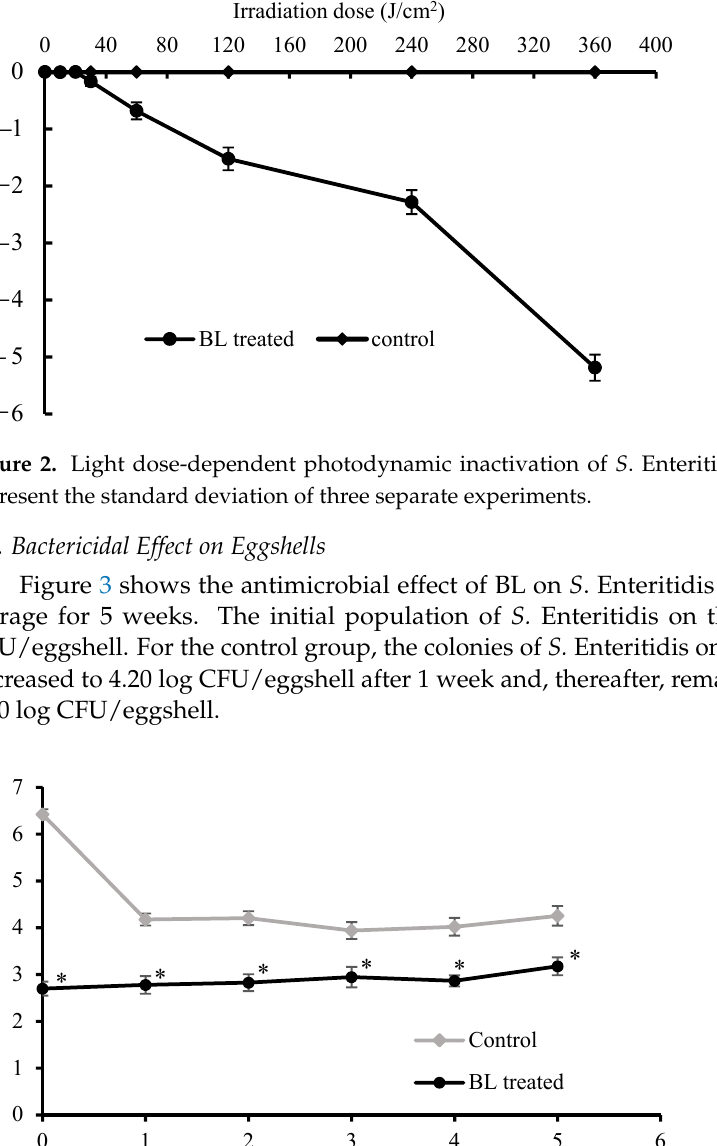
Figure 3. Inactivation of S . Enteritidis on polluted eggshells and microorganism count on eggshells after storage for 5 weeks. Asterisk (*) indicates significant ( p < 0.05) difference between BL-treated and control. Error bars represent the standard deviation of three separate experiments.